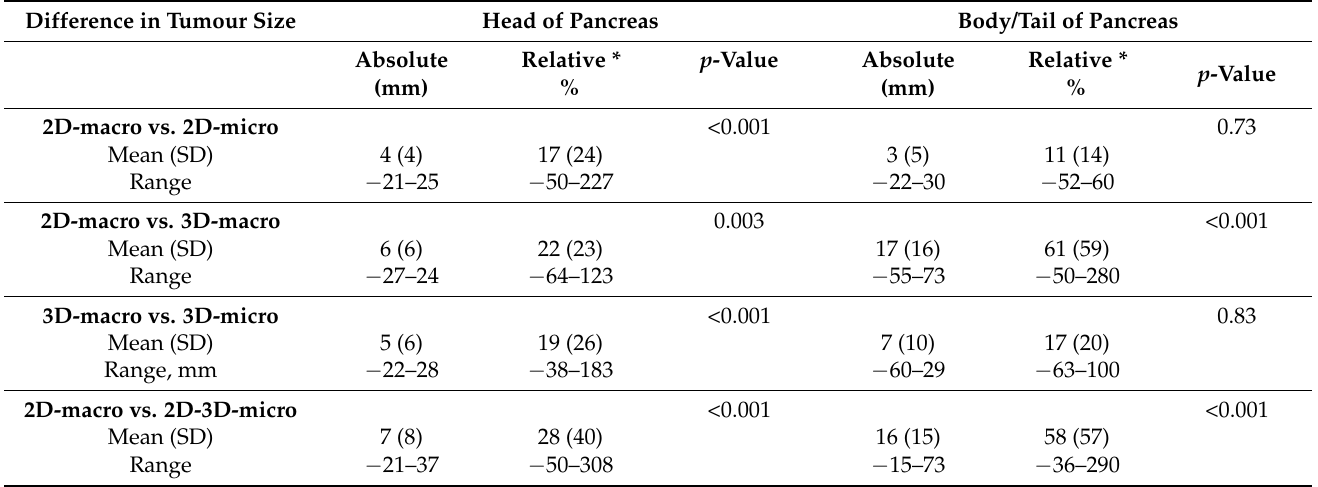
Table 3. Difference in tumour sizes obtained by various